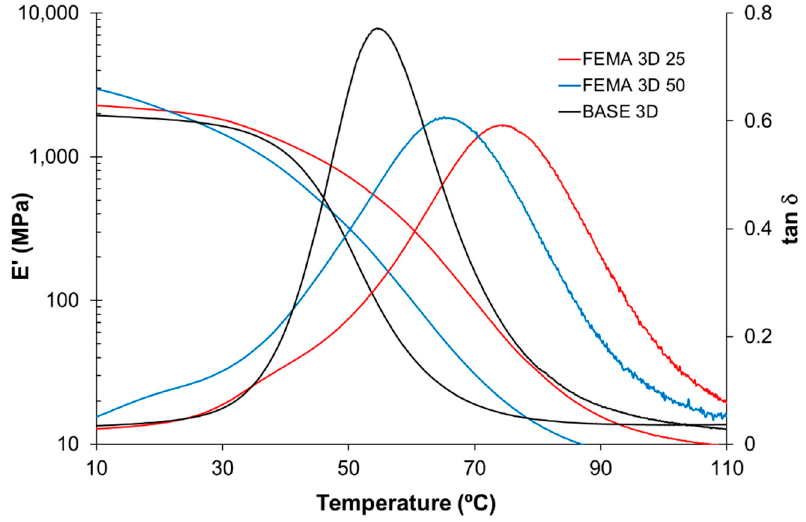
Figure 10. Storage moduli and tan δ of 3D printing formulations.